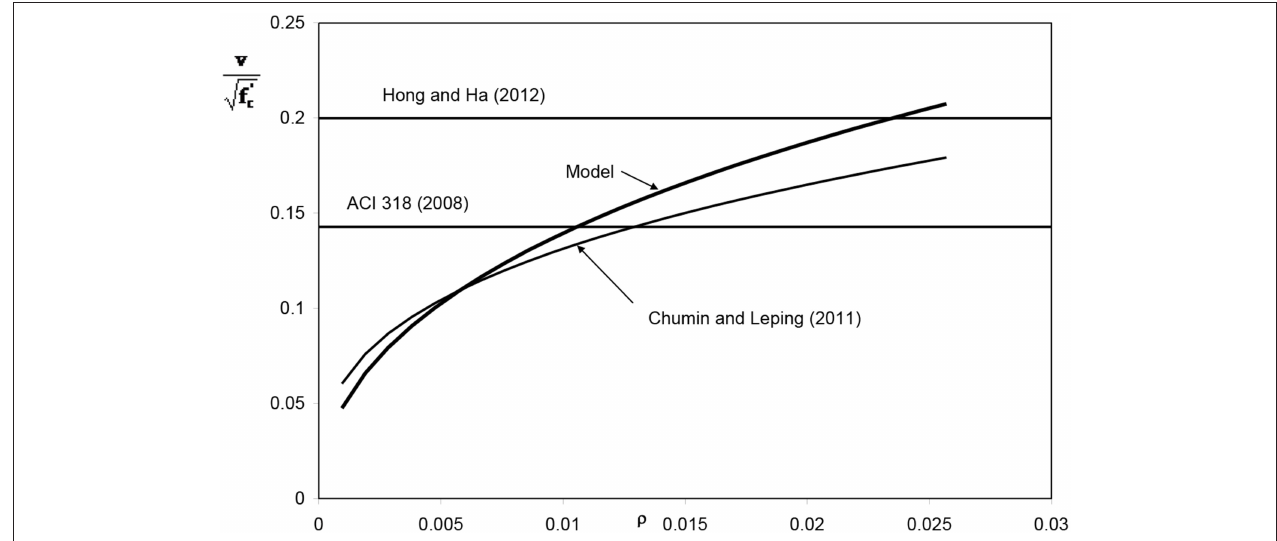
FIGURE 3 | Variation in shear strength due to bond splitting vs. geometrical ratio of steel bars.